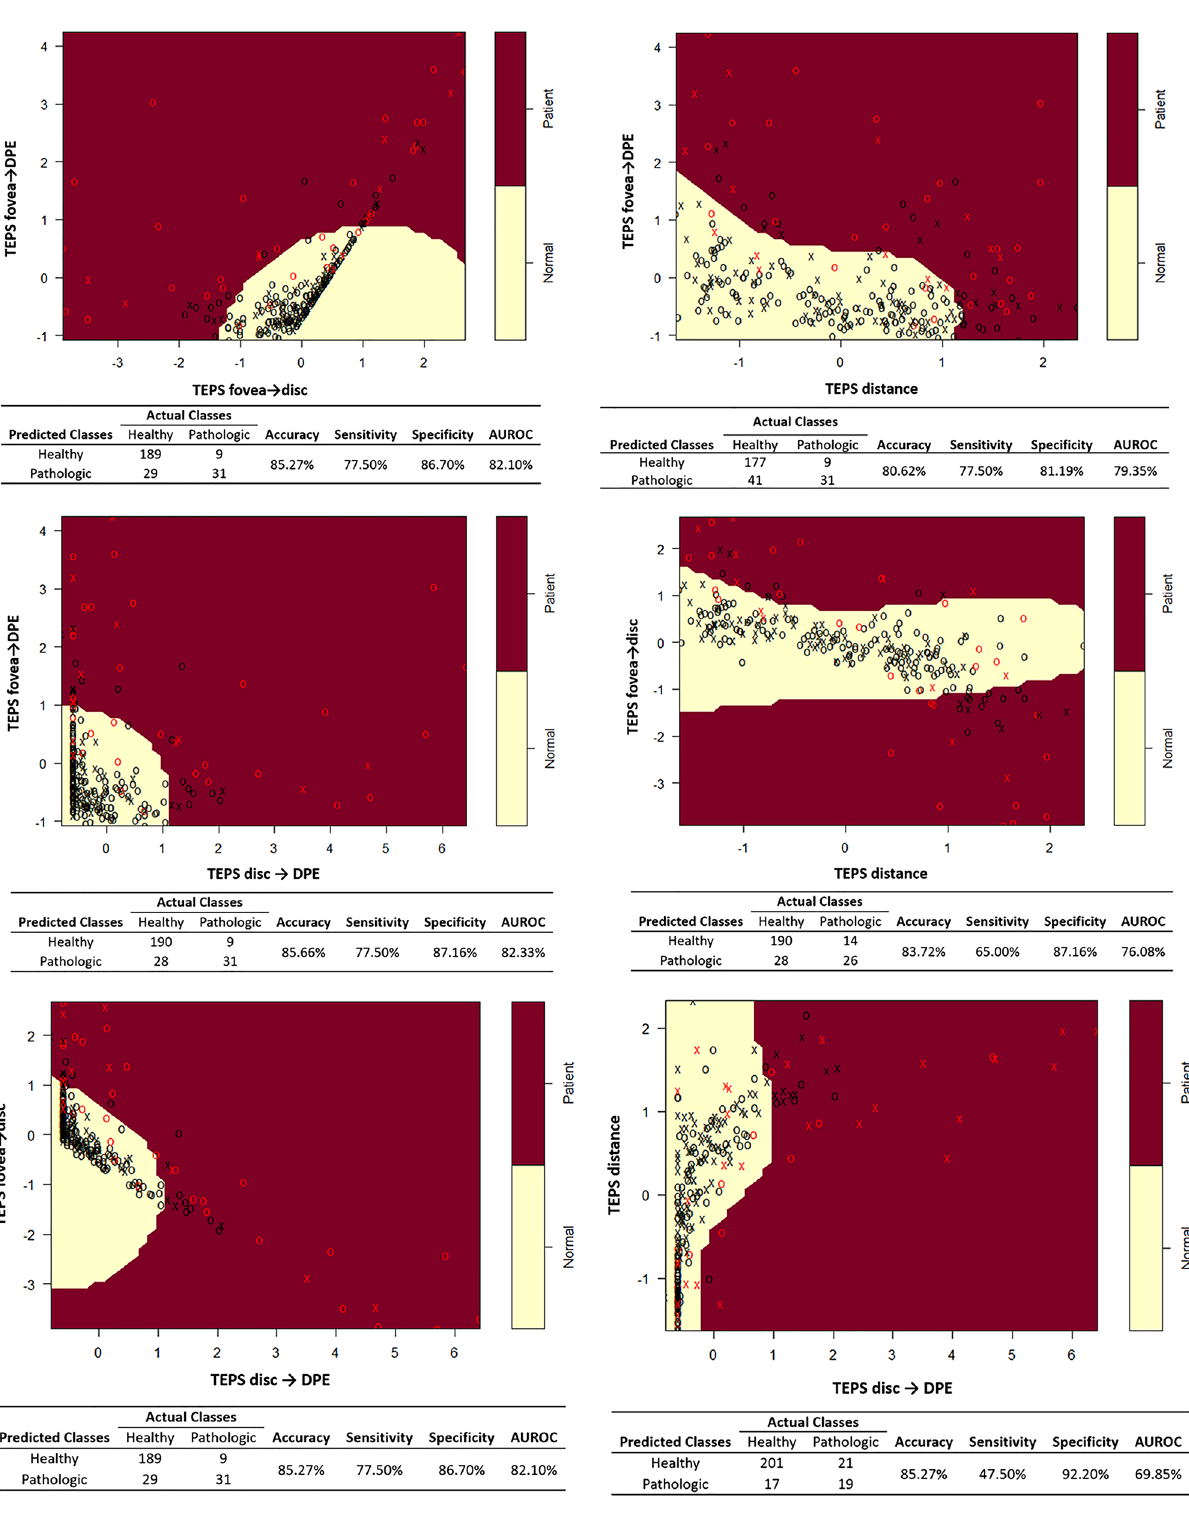
Figure 5. The two-dimensional plots and confusion matrix of individual pairs of the four TEPS indices. The nonlinear decision boundary classifying pathologic myopic eyes (red dot) and healthy eyes (black dot) is shown in each plot. Analysis was conducted in R (R Core Team 2014) and figures were produced using the package e1071 34